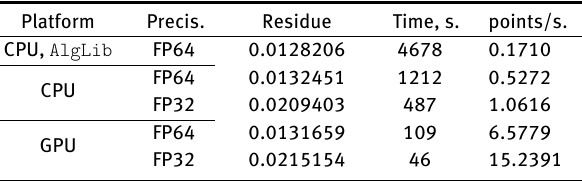
Table 4: Algorithm performance for various platforms and floating- point precisions